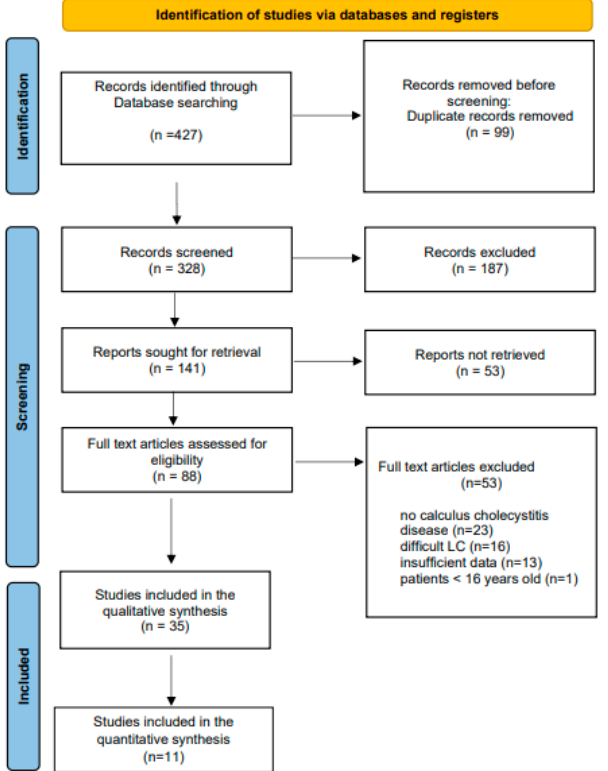
Figure 1. PRISMA flow diagram of study selection [20].